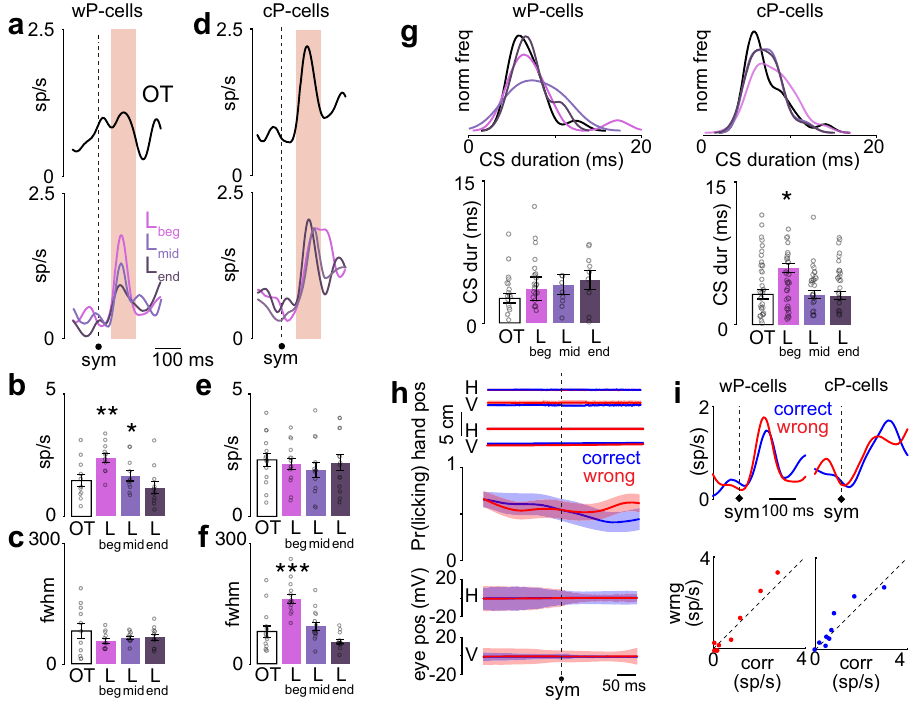
Fig. 2 CS activity after symbol onset was cell type speci fi c and learning dependent. a Top panel: spike density functions in the symbol epoch for wP-cells in the OT condition. Bottom panel: same for wP-cells in L beg , L mid , and L end . n = 11 wP-cells. b Peak fi ring rate of wP-cells in OT, L beg , L mid , and L end conditions in the symbol epoch. ** P < 0.01, * P < 0.05, two-tailed Wilcoxon signed rank test. n = 11 wP-cells. c Temporal dispersion of CS activity for wP- cells (estimated as the full width at half maximum fi ring rate) in OT, L beg , and L end conditions in the symbol epoch. n = 11 wP-cells. d Same as a but for cP- cells. n = 14 cP-cells. e Same as b but for cP-cells. n = 14 cP-cells. f Same as c but for cP-cells. *** P < 0.001, two-tailed Wilcoxon signed rank test, n = 14 cP- cells. g Left: duration of CS waveforms in OT, L beg, L mid , and L end conditions for wP-cells (left, n = 11 wP-cells) and for cP-cells (right, n = 14 cP-cells). Histograms were normalized on the maximum frequency among all epochs. * P < 0.05, two-tailed Wilcoxon signed rank test. h From top to bottom: mean horizontal (H) and vertical (V) hand positions of the hand that was associated with the symbol presented, mean H and V hand positions of the hand that was not associated with the symbol presented, mean probability of licking, mean H and V eye positions for correct (blue) and wrong (red) trials. n = 25 sessions. i Top: CS activity during L beg separated into correct (blue) and wrong (red) trials for wP-cells (left) and cP-cells (right). Bottom: scatter plot of peak neural activity during correct and wrong trials for individual wP-cells (left) and cP-cells (right). Data shown as mean ± s.e.m. Source data are provided as a Source Data fi correct and wrong trials (Fig. 2h). After the symbol onset, neither type of P-cells predicted the impeding decision ’ s outcome (Fig. 2i; wP-cell: P = 0.85, two-tailed Wilcoxon signed rank test, and cP- cell: P = 0.88, two-tailed Wilcoxon signed rank test).